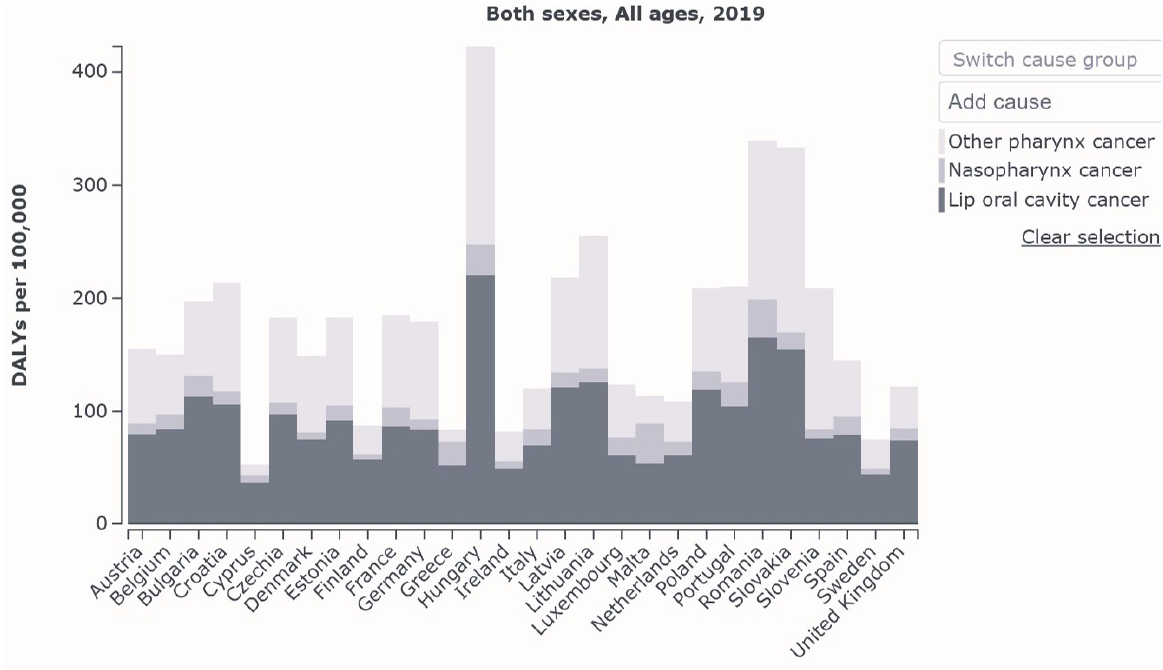
Figure 5. LOCP age-standardised DALYs 2019. Source: Institute for Health Metrics Evaluation. Used with permission. All rights reserved